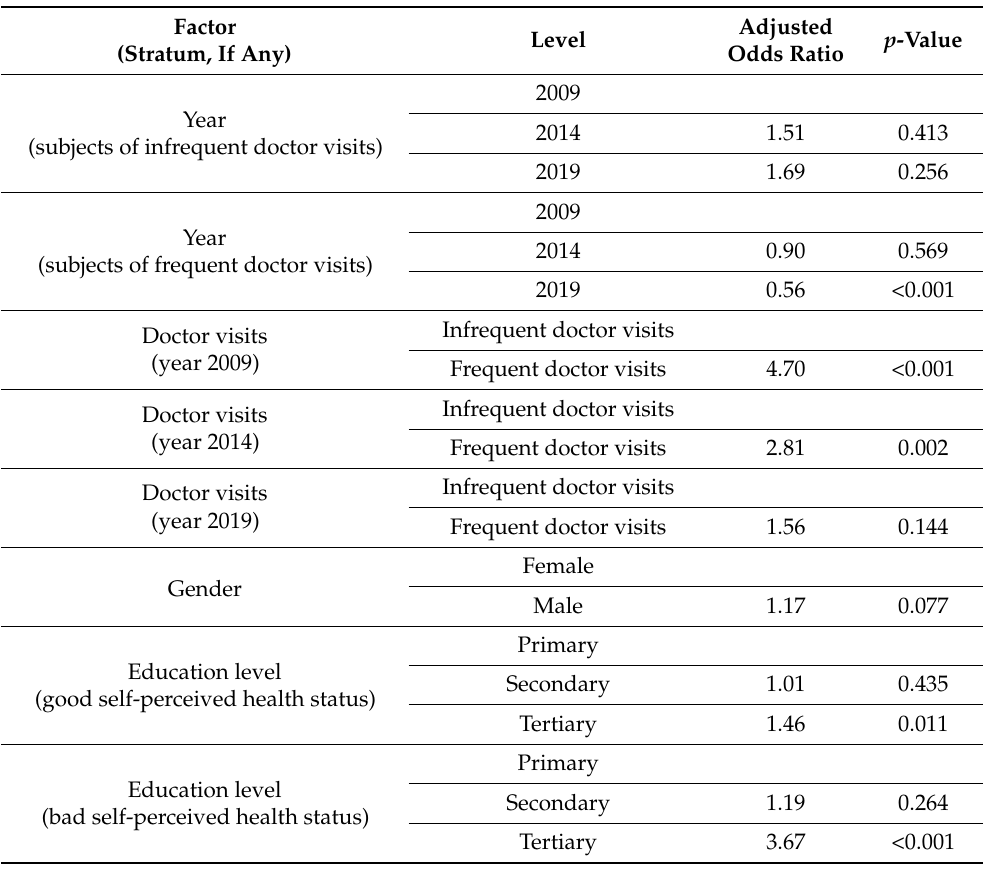
Table 2. Factors that influenced influenza vaccination among the residents aged 65 or above in Hungary based on the multivariate logistic regression model. Factor (Stratum, If Any)